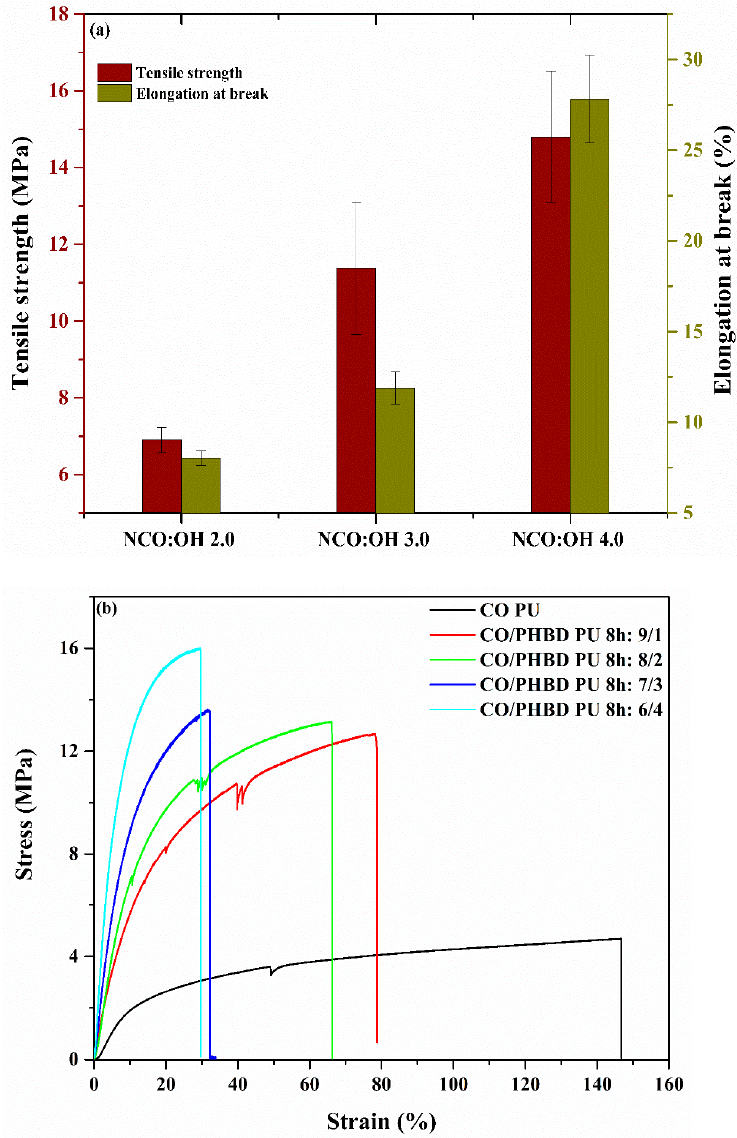
Figure 5. ( a ) Effect of NCO/OH ratio (CO/PHBD ratio: 6/4) and ( b ) CO/PHBD ratio (NCO/OH ratio: 4.0) on mechanical properties of the resulting PU.